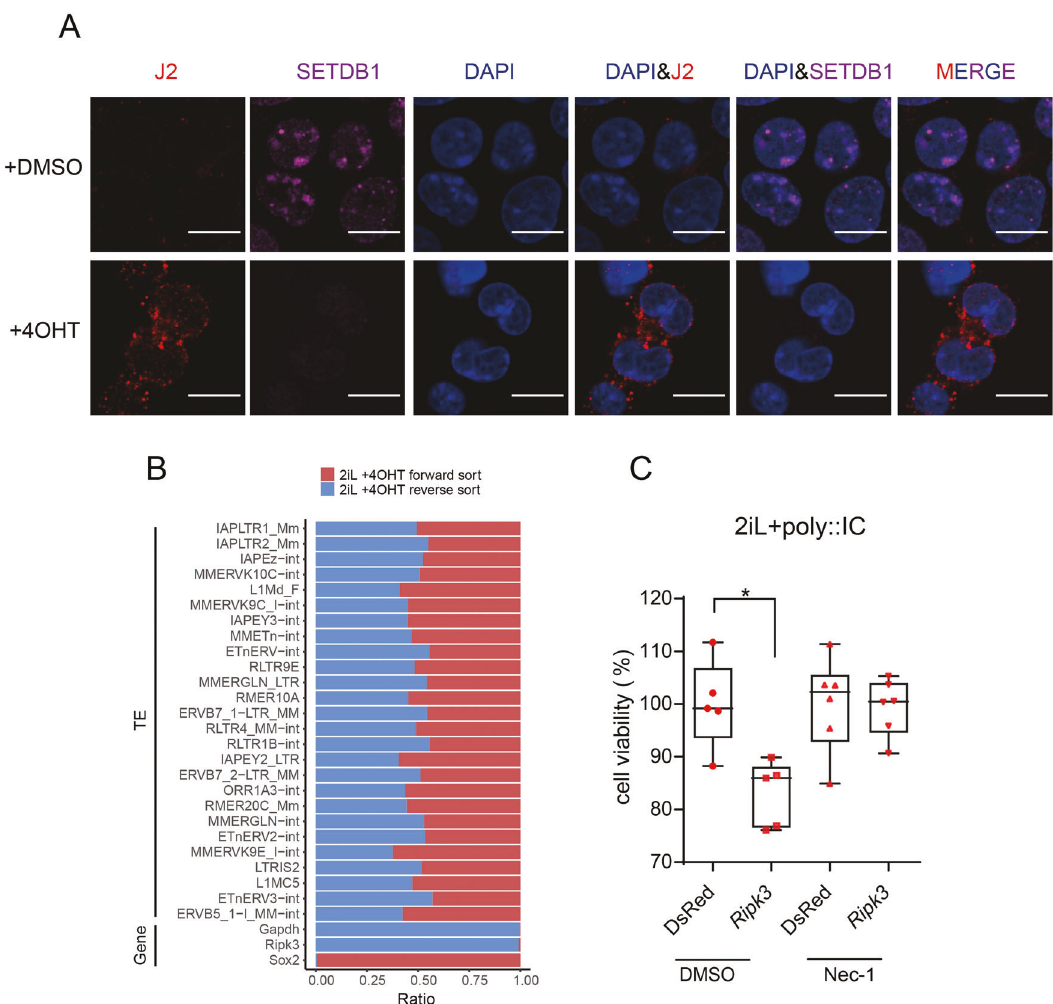
Fig. 5 ERVs activation mimic virus invasion to induce necroptosis. A Immuno fl uorescence of J2 and SETDB1 in Setdb1 cKO cells treated with DMSO or 4OHT. Scale bars, 10 μ m. B Heatmap shows transcription direction of TEs and genes analyzed from strand-speci fi c RNA-Seq. C Cell viability assay of Setdb1 cKO cells overexpressing dsRed/ Ripk3 transfected by poly(I:C) using CCK8 test. Cells were treated with DMSO or Nec-1. ( n = 6, 2 biological replicates; error bar, SD; * p <